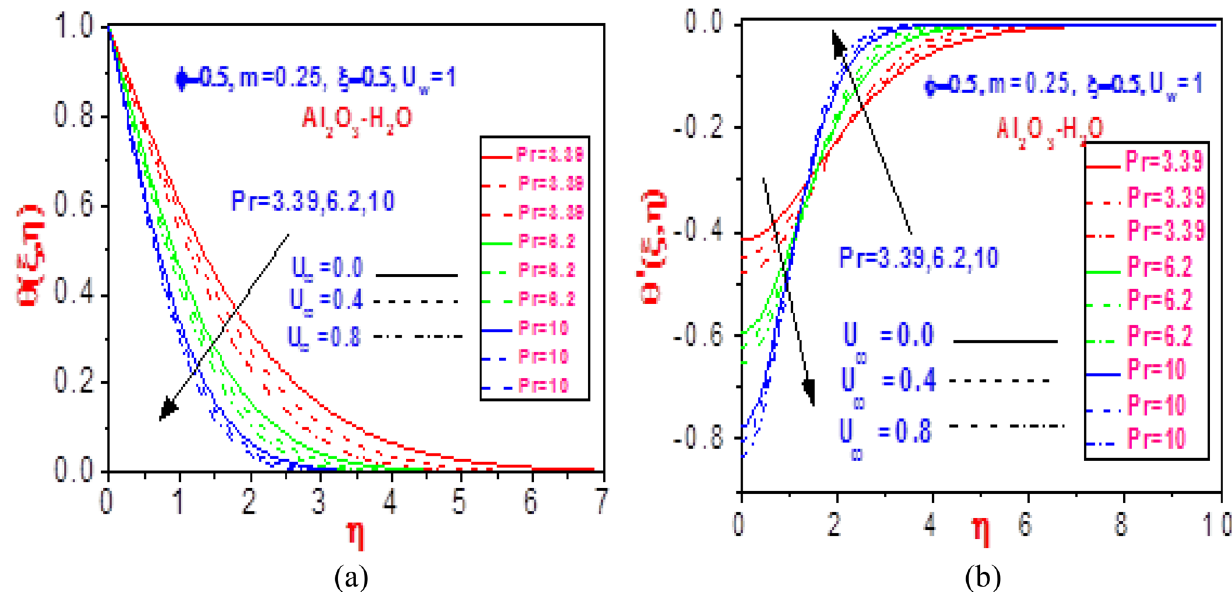
Figure 11. Profiles of ( a ) temperature θ(ξ , η) and ( b ) missing temperature slope θ ′ (ξ , η) with different values of U ∞ and Pr for Al